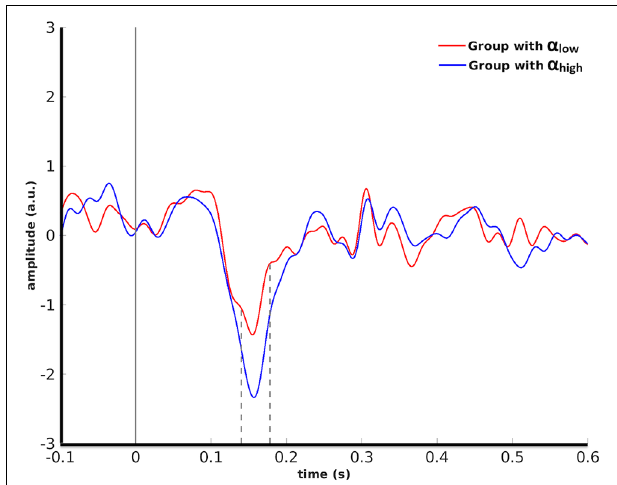
FIGURE 3 | Grand average over the participants’ evoked responses to human faces in the right IPS for the α low vs. the α high conditions. Dashed lines indicate the time interval at which the difference between the two conditions was found to be significant by cluster-based permutation.